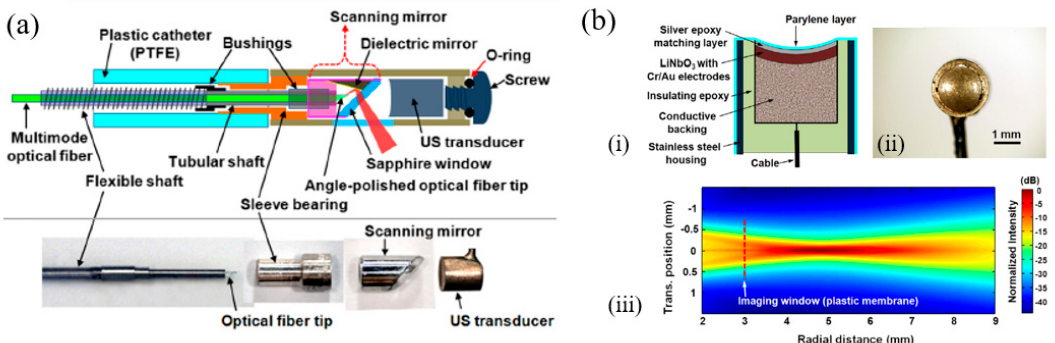
Figure 14. ( a ) Schematic (top) and photograph (bottom) of the distal section of the catheter-based photoacoustic endoscope. ( b ) Schematic (b-i), photograph (b-ii), and simulated transmission acoustic intensity map (b-iii) of the focused LiNbO 3 -based transducer (Reproduced with permission from SPIE [40]).